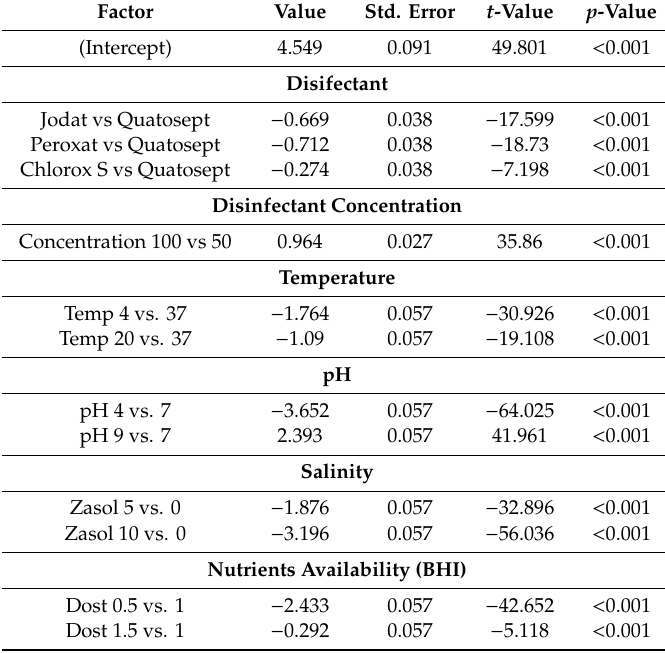
Table 7. Predictive factors for the reduction of bacteria number in biofilm identified by Linear Mixed E ff ects Model